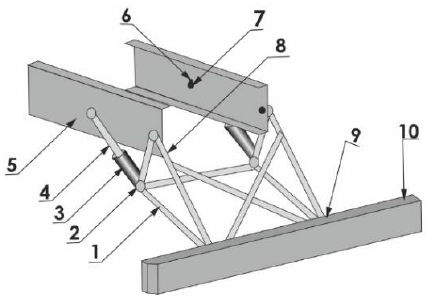
Figure 8. RUPD with energy absorbers in the guard bar and its supports. 1 — Truss-form support system; 2 — Pivotal joint between the energy absorber and the RUPD support; 3 — Energy absorber; 4 — Absorber arm; 5 — Vehicle frame; 6 — Cotter pin; 7 — Pin; 8 — Tapered stud bolt; 9 — RUPD guard bar; 10 — Energy-absorbing surface.